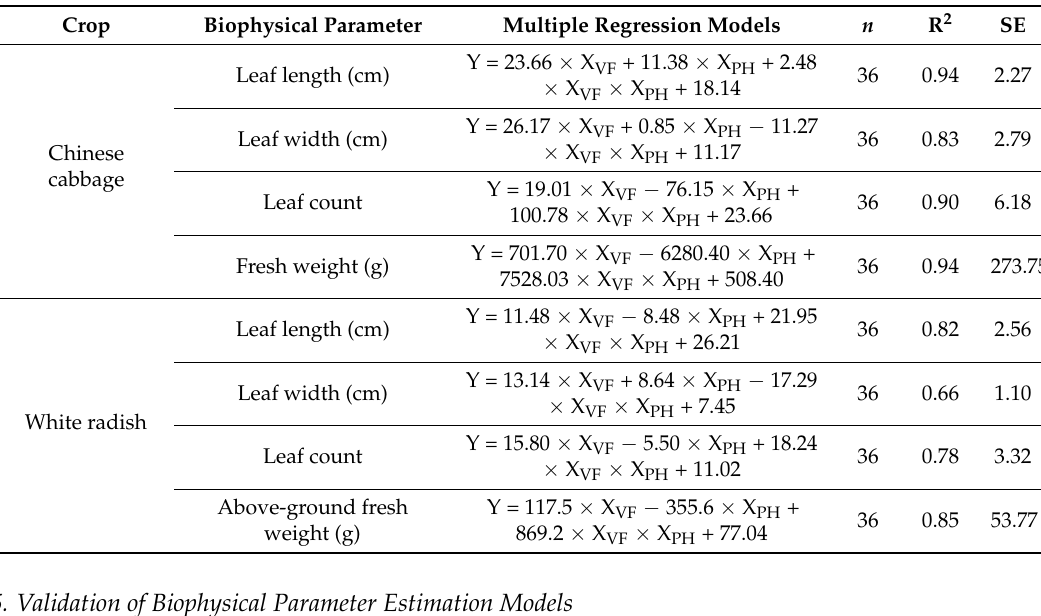
Table 7. Results of multiple linear regression equations to estimate the biophysical parameters of Chinese cabbage and white radish using their vegetation fractions (VFs) and plant heights (PHs) obtained from unmanned aerial vehicle-red, green and blue (UAV-RGB) images: Y = Biophysical parameters; X VF = Vegetation fraction value; X PH = Plant height value; n = Number of